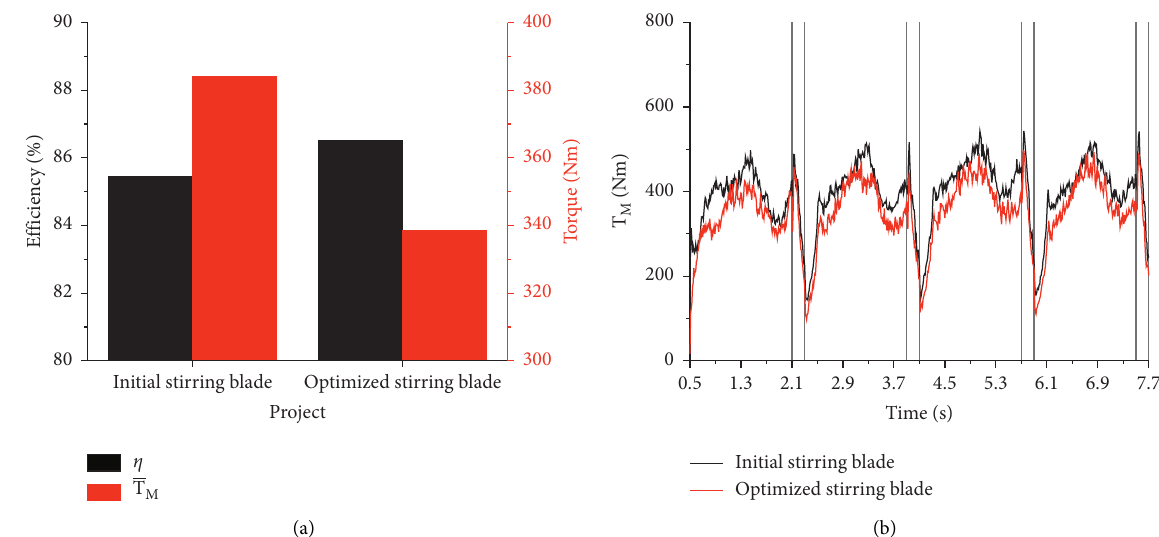
Figure 23: The simulation results of the initial stirring blade and the optimized stirring